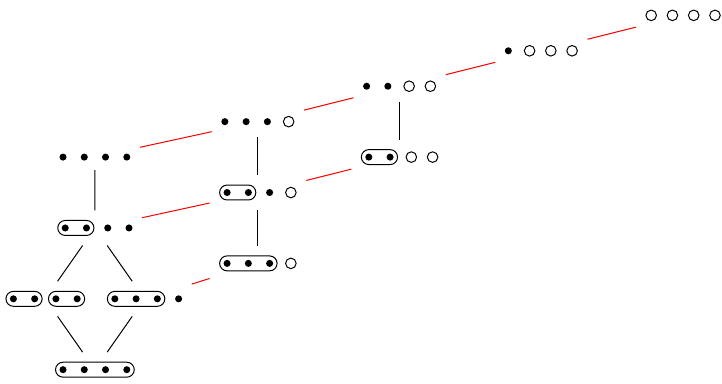
Figure 6. The Hasse diagram obtained from shrinking (red) and colliding (black) 4 D3 branes inside a stack of N D7 branes. We draw D3 branes with a size as circles , D3 branes of zero size as dots , and denote coincident stacks of D3 branes by drawing a line around them